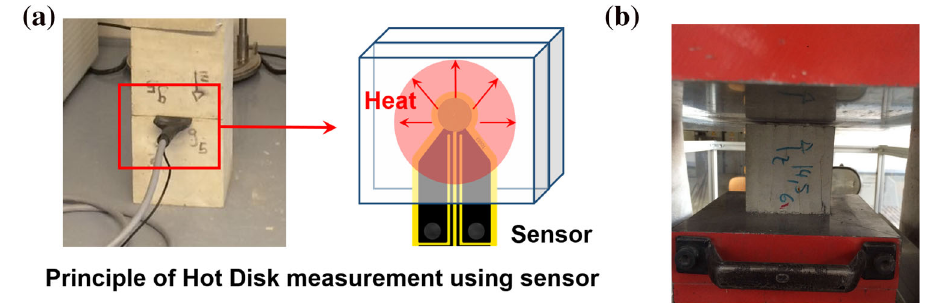
Fig. 3 The use of the devices for evaluating material properties: a Hot Disk device and its operation principle, b Compressive strength